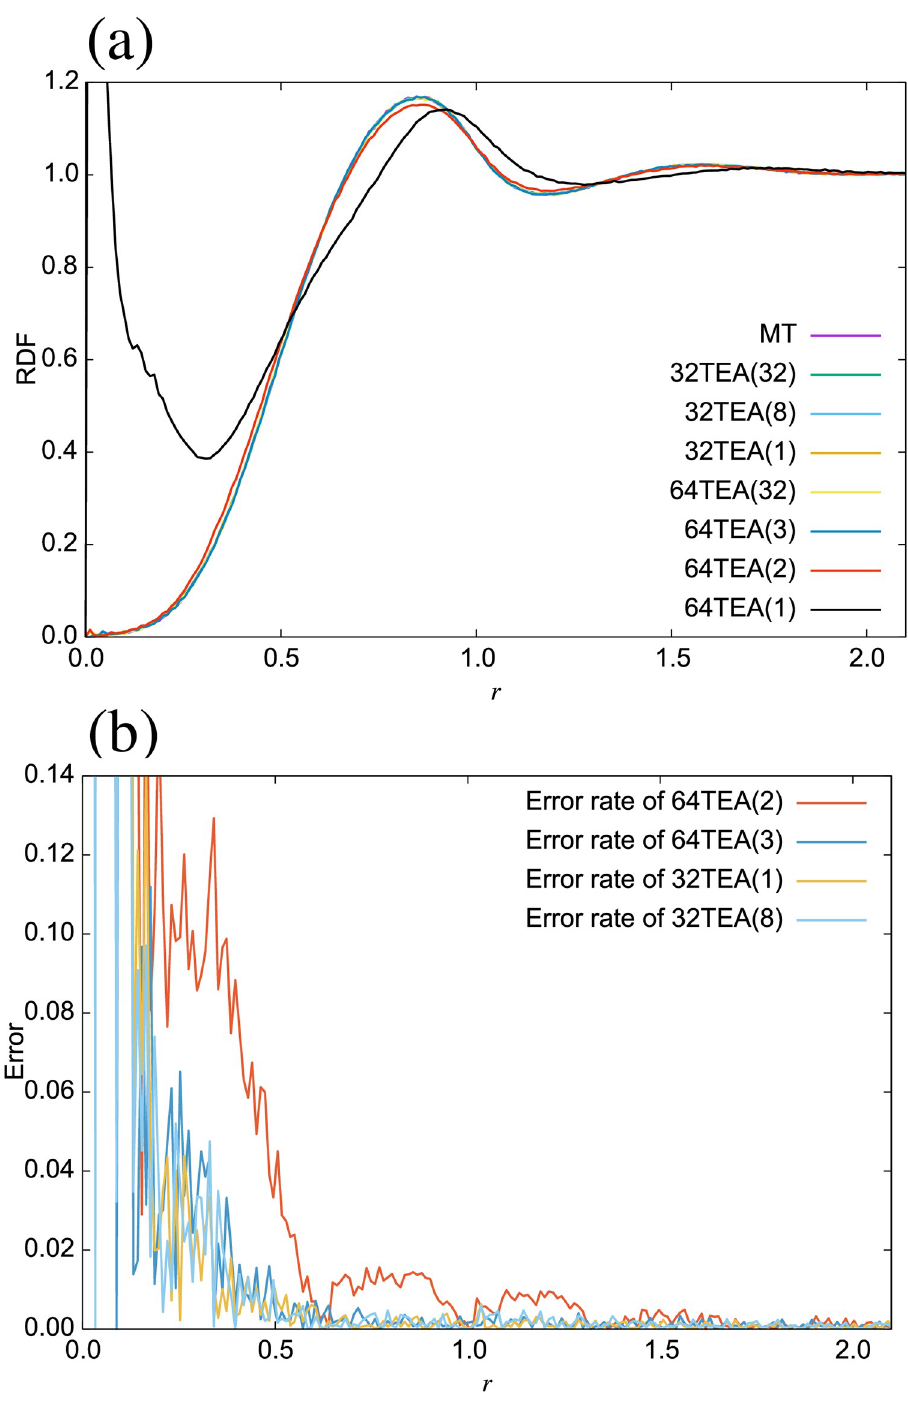
Fig 6. (a) Radial distribution function, (b) error rate of radial distribution function.